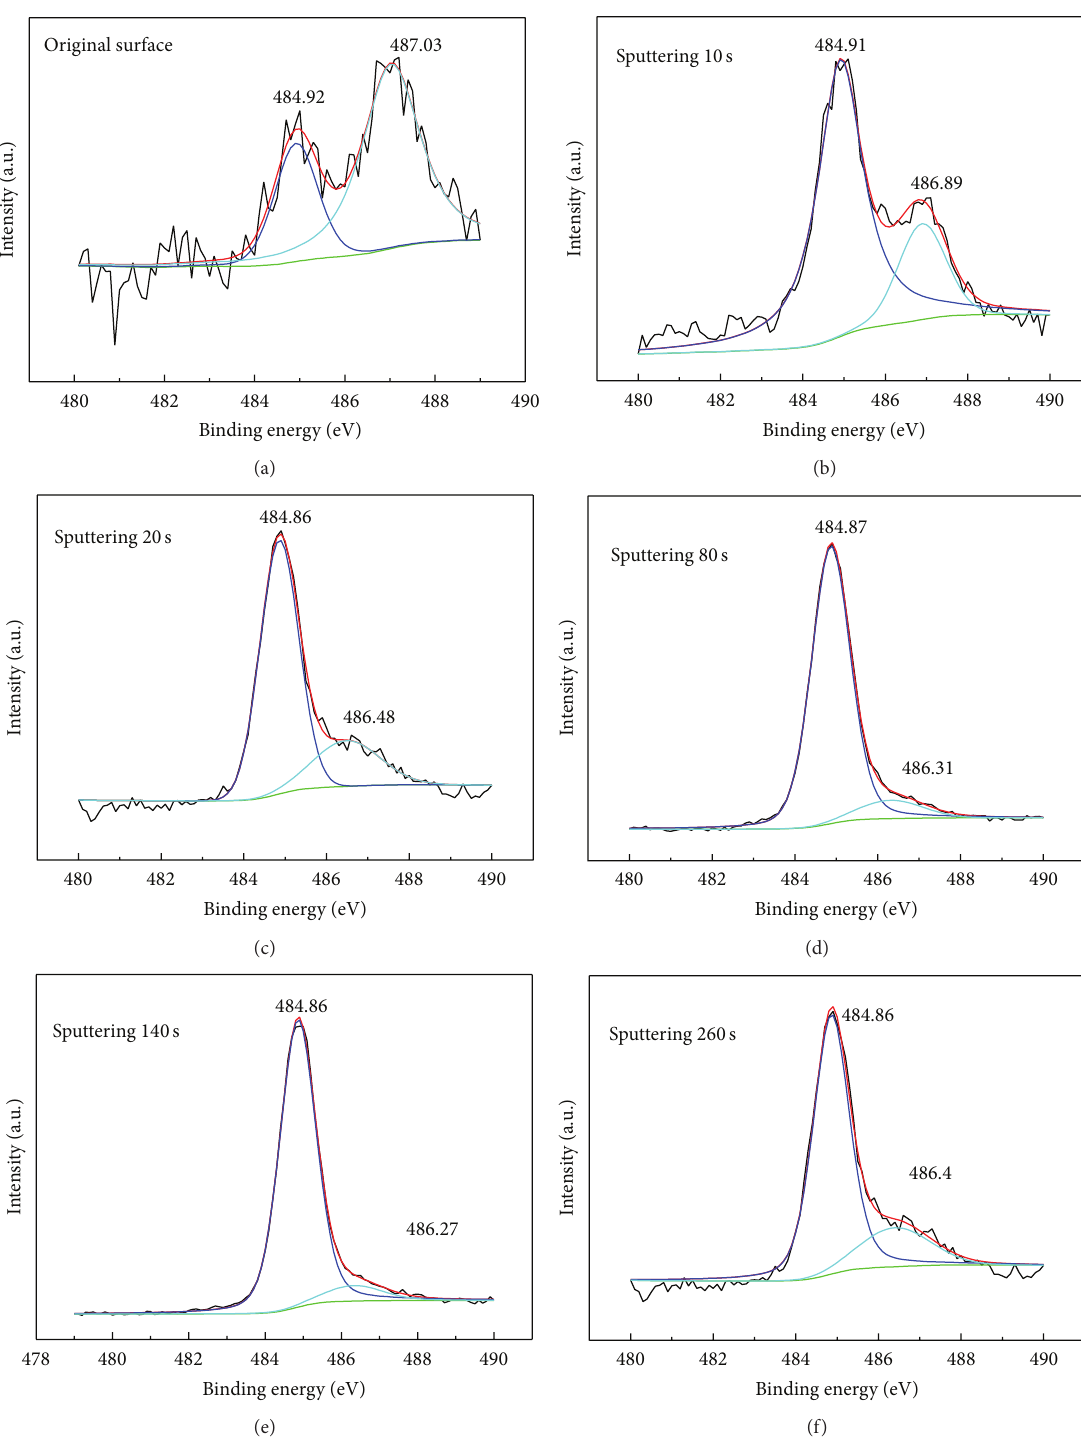
Figure 7: Sn 3d5/2 spectra of SBZA sample exposure at 170 ∘ C for 7 min after etching for (a) 0 s (initial surface), (b) 10s, (c) 20 s, (d) 80s, (e) 140s, and (f) 260